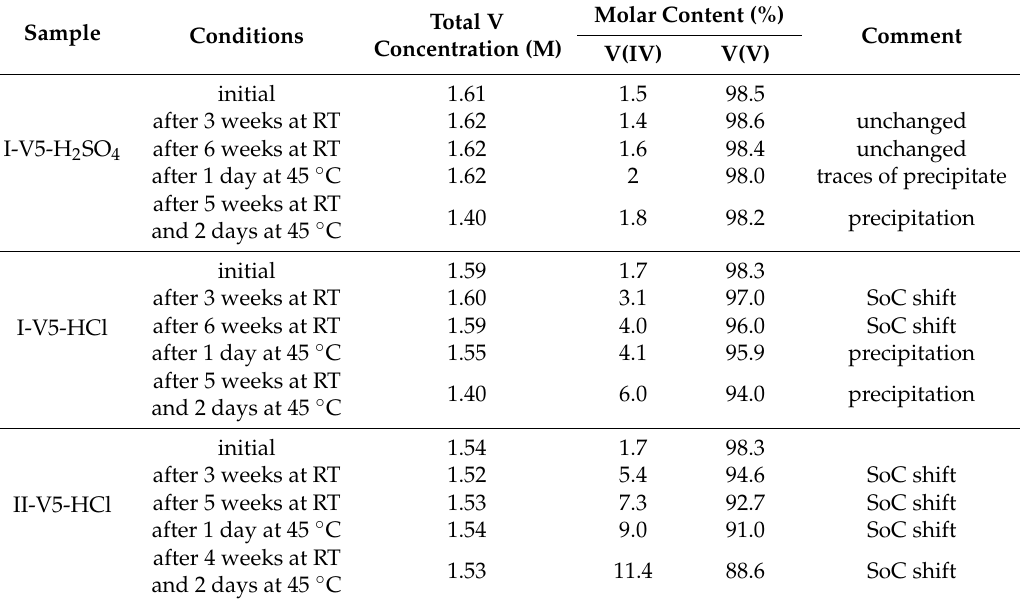
Table 5. Titration results for the catholyte samples with a HCl and H 2 SO 4